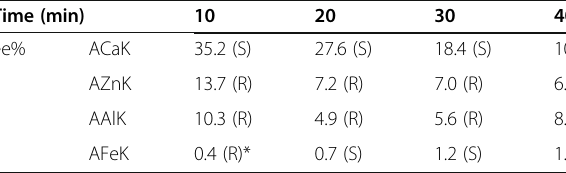
Table 4 Obtained ee% results for 120 min in the release medium Time (min)